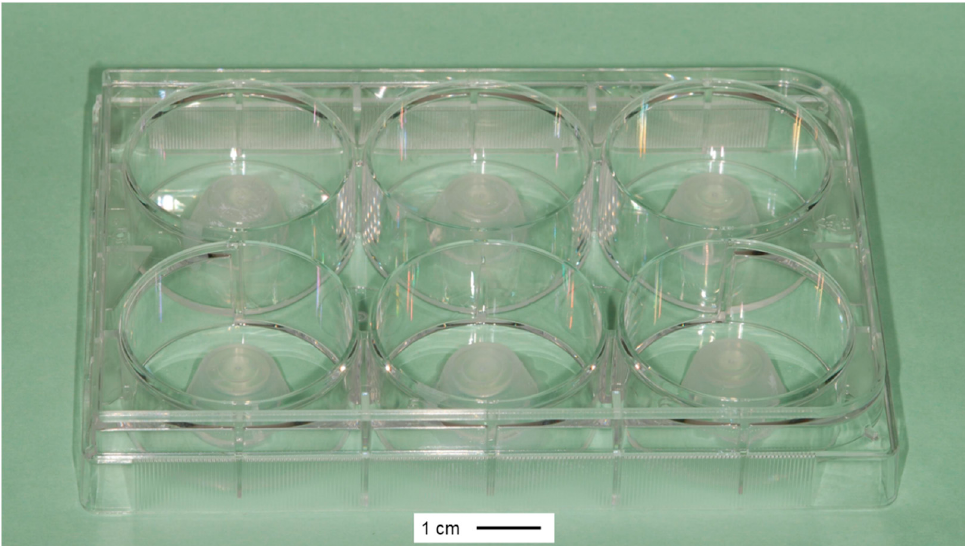
Figure 1. Culture plate for ex-vivo corneal assay featuring plastic pedestal corneal conformers.